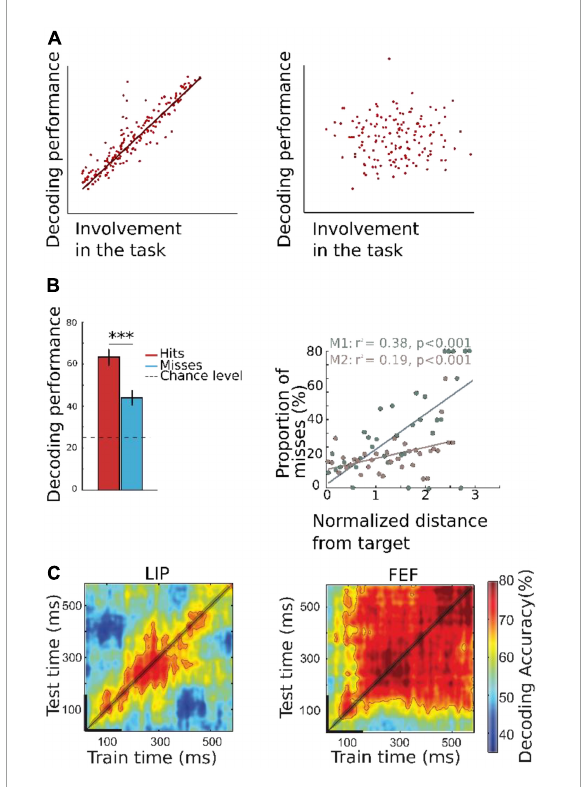
FIGURE2 (A) Schematic representation of theoretical relationship between decoded information and behavioral proxy of decoded internal brain state. Left: Decoded information is highly correlated with the underlying cognitive brain state, and the behavioral proxy of this decoded brain information (hit, misses, reaction time) is strongly correlated with the decoded information. Right: If the decoder is not a good estimator of covert brain information, there is no correlation between decoded information and the behavioral proxy to the decoded cognitive function. Please note that this type of approach is more robust when the output of the decoder is continuous and non-categorial. (B) Decoded spatial locus of attention correlates with behavioral performance. Decoding was performed using MUA activity recorded from two rhesus monkeys, while the animals played a cued target detection task. On each trial, a cue was presented to the monkeys who were trained to keep their gaze at the center of the screen while orienting their covert attention to the cued location (one amongst four possible locations), to detect. The trained algorithm aimed at decoding the quadrant to which attention was oriented (left) or the actual ( x- , y- ) location of the attentional spotlight (right). Left: Decoding accuracy as a function of behavioral performance. Decoding accuracy is higher for correct detection trials than for miss trials, in which the monkeys did not properly identify the target, indicating that the decoding algorithm is able to capture internal attentional orientation information. Right: Proportion of misses as function of distance between the target and the decoded position of attention in X - Y - coordinates. Farther is the decoded position from the target at time of presentation, higher is the probability of missing the target (adapted from Astrand et al., 2016). (C) Temporal generalization of two algorithms trained with MUA activity from two different brain regions known to have a role in covert attention: lateral intraparietal area LIP (left) and frontal eye field FEF (right). The algorithm is trained on successive times intervals and for each training interval, tested on all